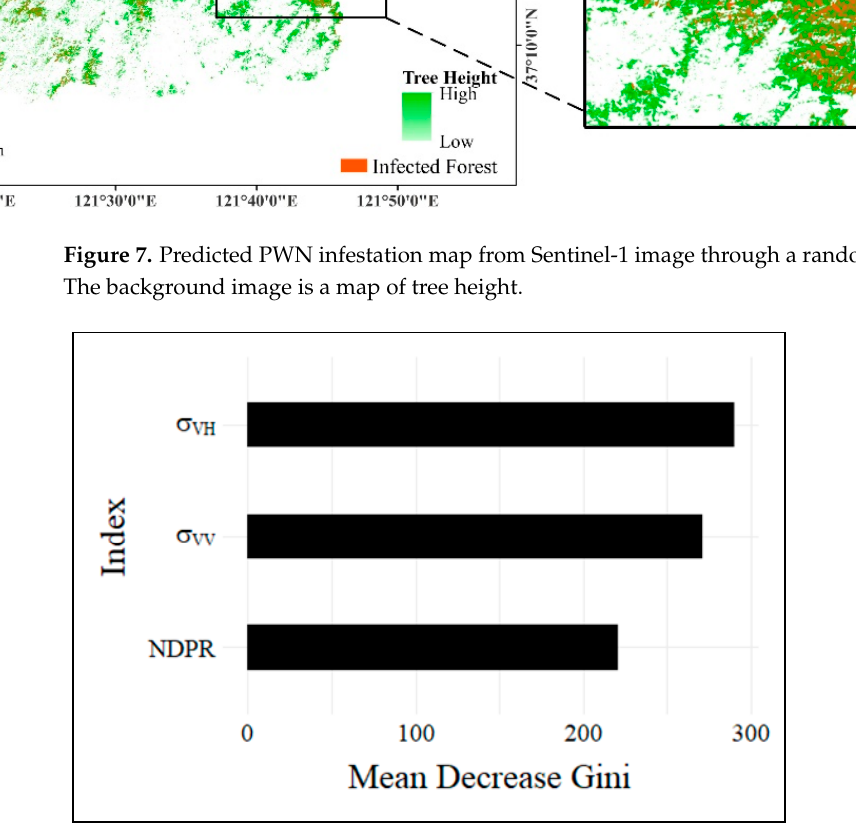
Figure 8. Importance evaluation of the input variables of the random forest algorithm used for predicting PWN infestation from Sentinel-1 image.